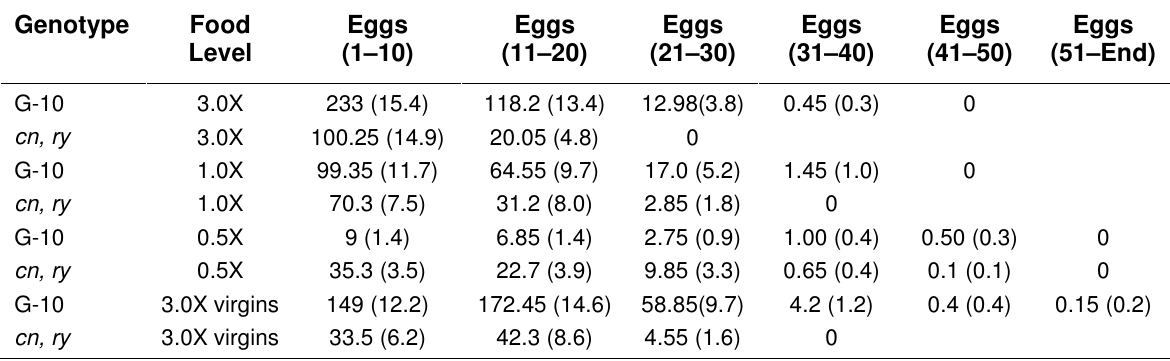
SP Increases Average Egg Laying in Females during 10-Day Periods